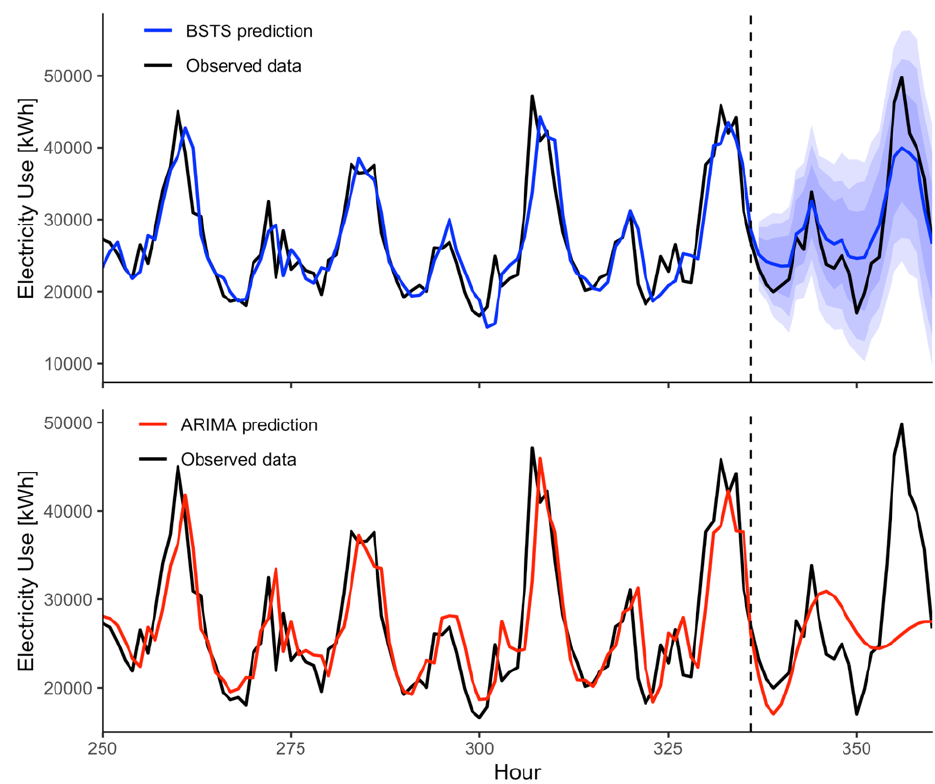
Figure 1. Forecasting results for the BSTS model (on top in blue) and the ARIMA model (at the bottom in red). In the top graph, the BSTS model produces 60th, 80th, and 90th percentile prediction intervals as represented by the dark, medium, and light blue bands,